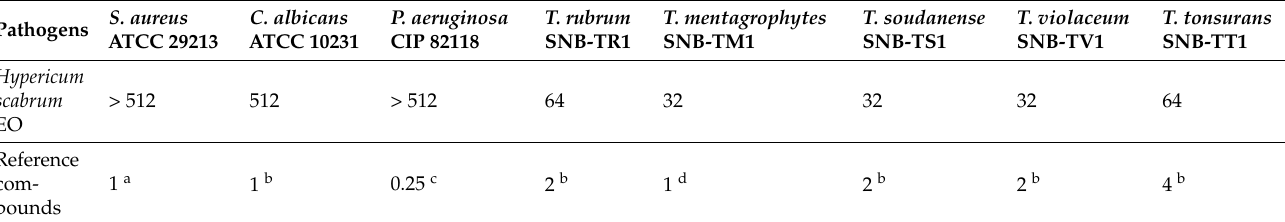
Table 2. Antimicrobial activity (minimal inhibitory concentration (MIC) in µ g/mL) of Hypericum scabrum EO. S. aureus Pathogens ATCC